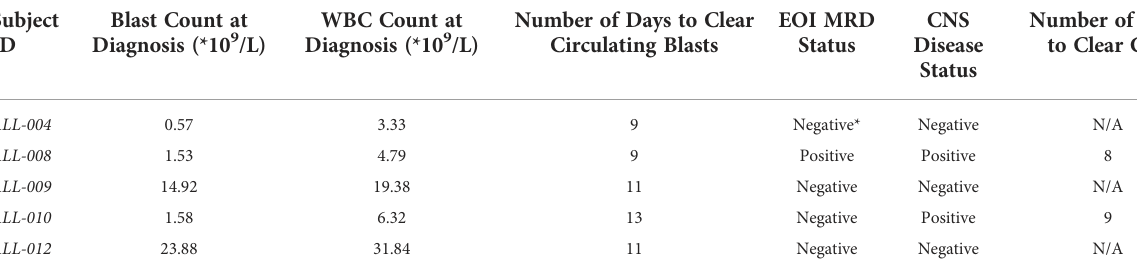
TABLE 1 Patient